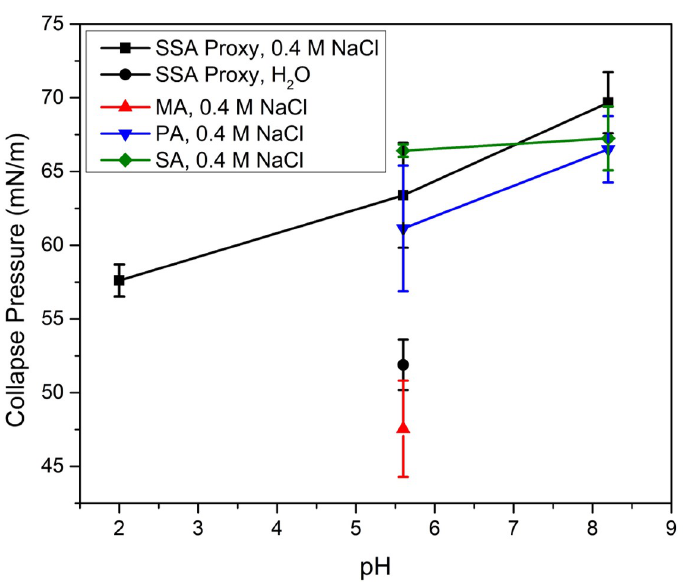
Figure 5. Collapse pressures of the SSA proxy film and its individual fatty acid components plotted as a function of subphase pH (see Supplementary